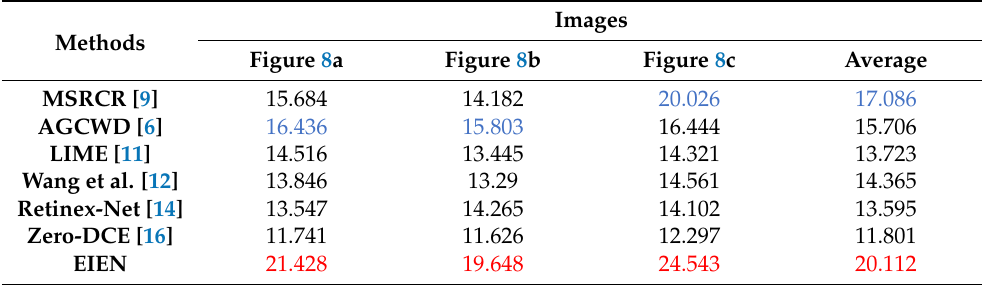
Table 4. PSNR results for different algorithms. The best result is in red whereas the second best one is in